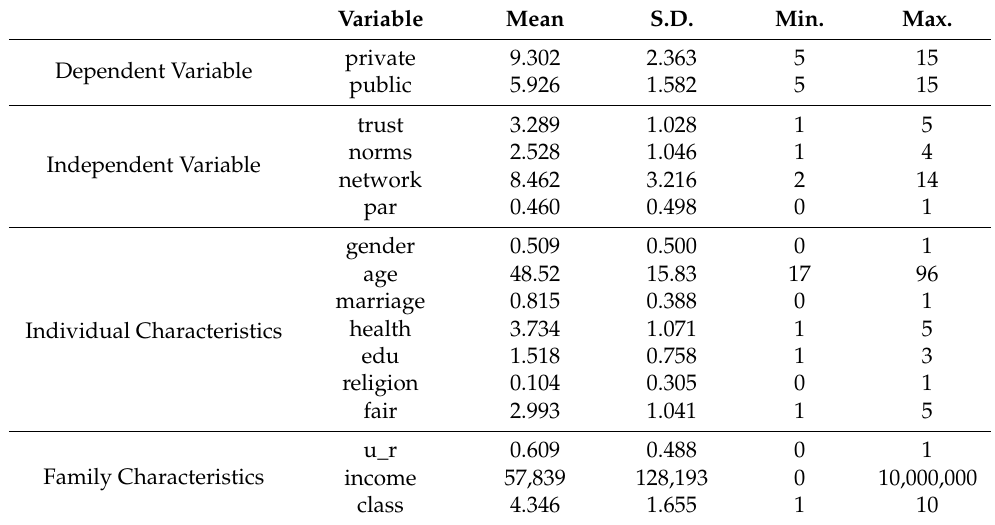
Table 4. Sample profile ( N =